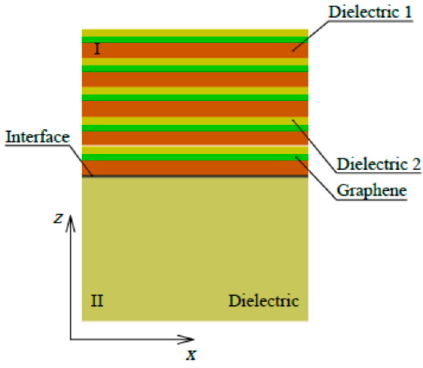
Figure 6. Schematic of graphene-dielectric multilayered MM.